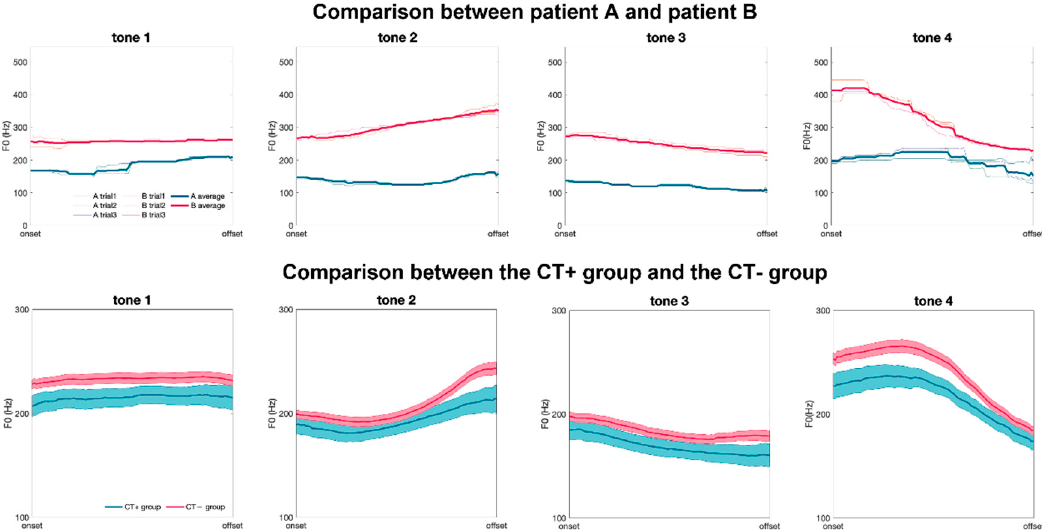
Figure 3. Comparison of acoustic voice analysis results. Each panel shows F0 as a function of normalized time, from the beginning to the end of each word. Panels from left to right represent the F0 of tones 1 to 4 in sequence. The upper row is the comparison between Patients A and B. The three thin blue and red lines represent the F0 contours of the three trials of Patients A and B, respectively, and the bold lines represent the means of the three trials for each patient. The lower row compares the CT+ group (blue band) and CT − group (red band). The bold line is the average of F0, and the width of each band represents the standard error of the mean (SEM).